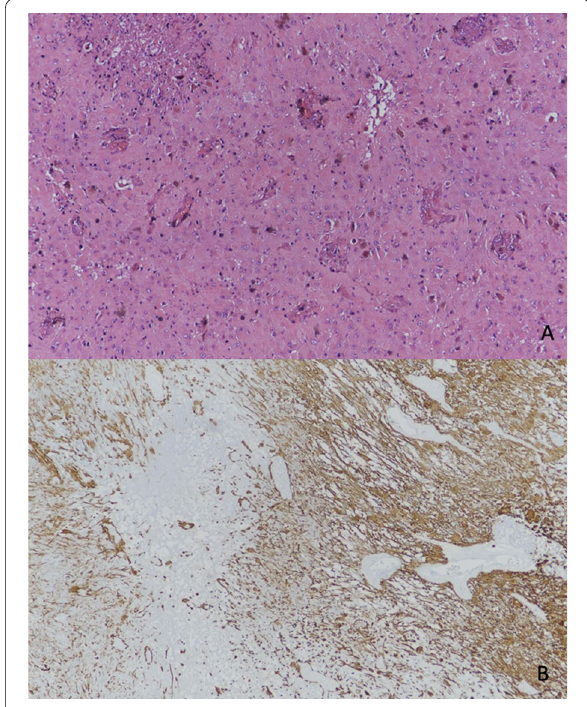
Fig. 4 Gemistocytic cells, areas of necrosis and vascular endothelial proliferation. A H&E*100. B GFAP positivity